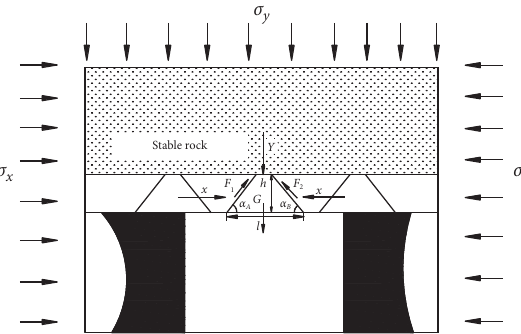
Figure 3: Model for analyzing the stability of the hexahedron rock blocks in a